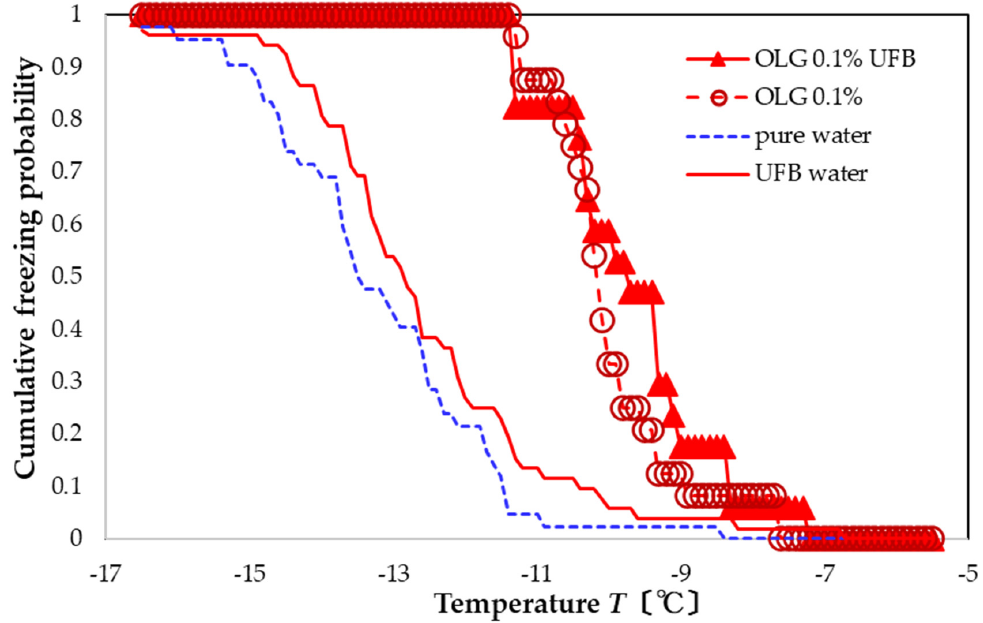
Figure 8. Freezing curve of aqueous solution with 0.1 wt% OLG dissolved in water with UFBs (solid red). Other curves shown for comparison.